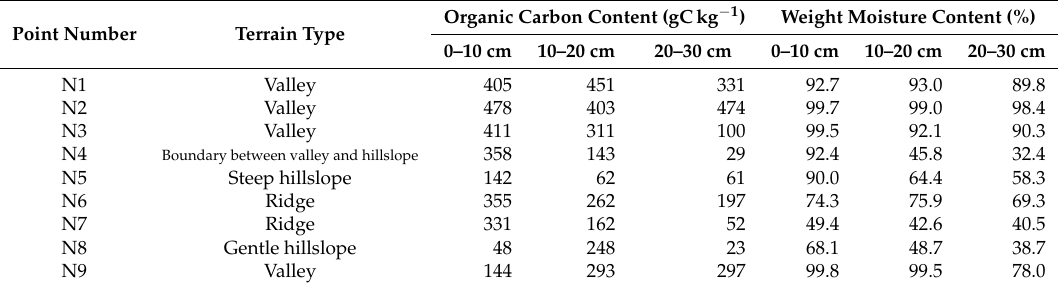
Table 2. Organic carbon contents and weight moisture contents at each point of the research site in September 2016 (Tyrma, Khabarovsk,